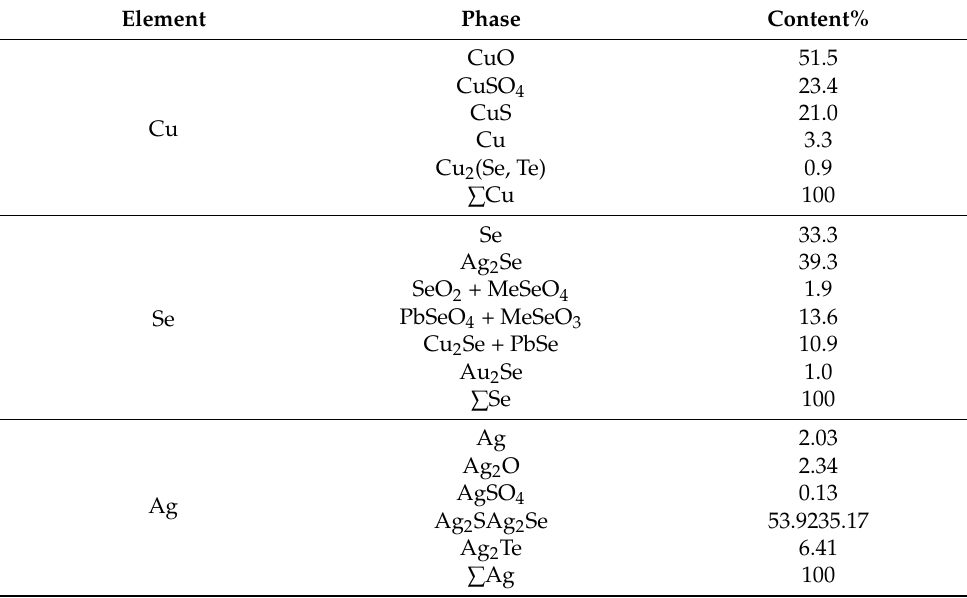
Figure 2. Distribution maps of the main elements present in the coppered anode slime. Table 2. Mineral phase composition of copper anode